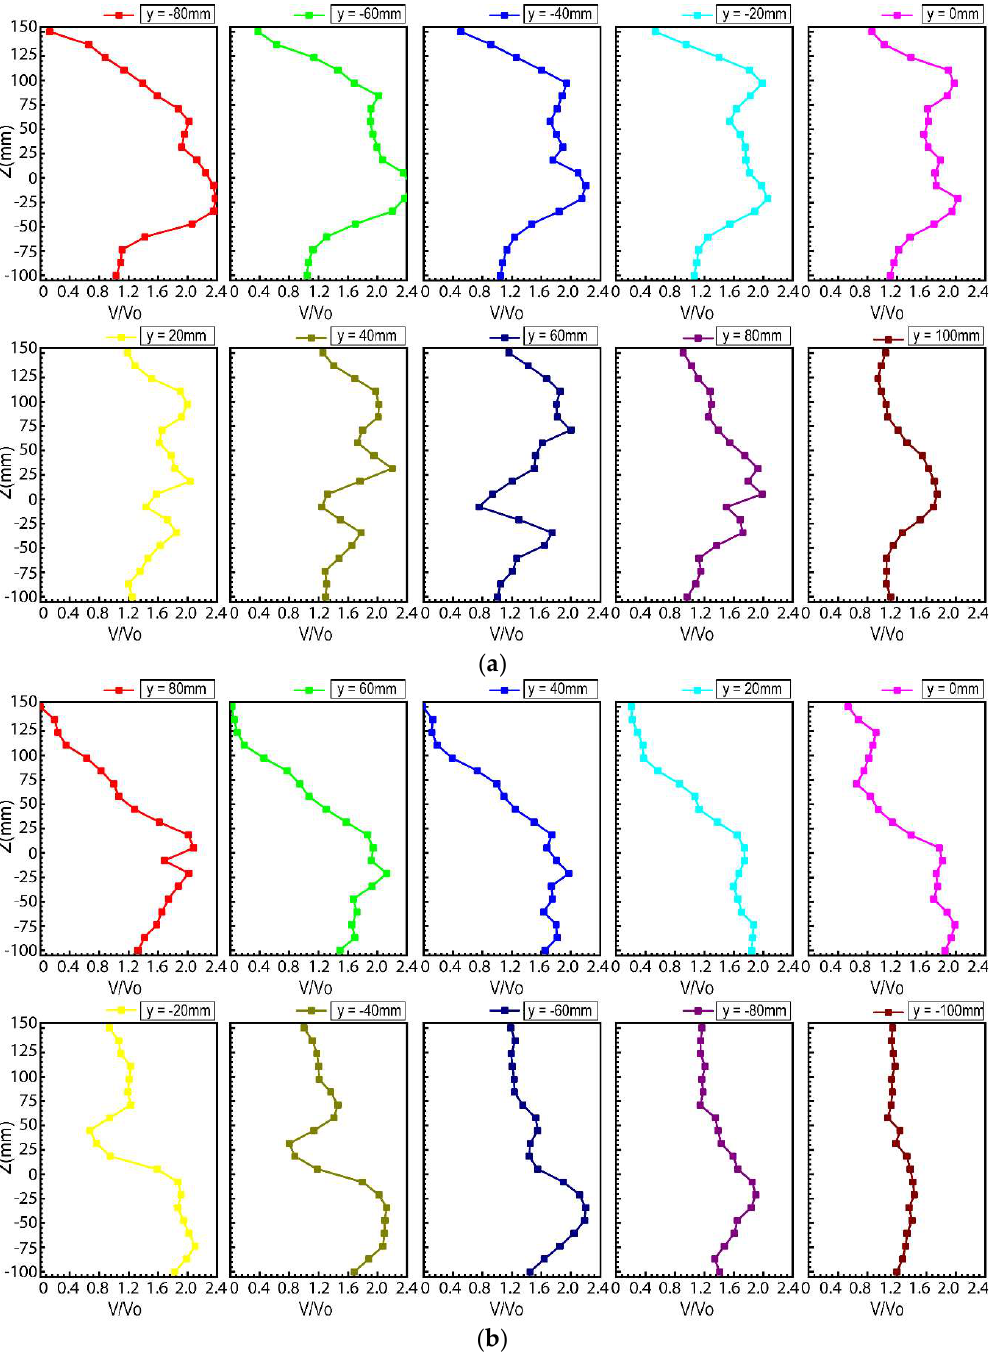
Figure 9. Dimensionless axial velocity distribution curves at different longitudinal tangents ( 𝐽 = 0.5). ( a ) −30° oblique drive conditions ( b ) +30° oblique drive conditions.